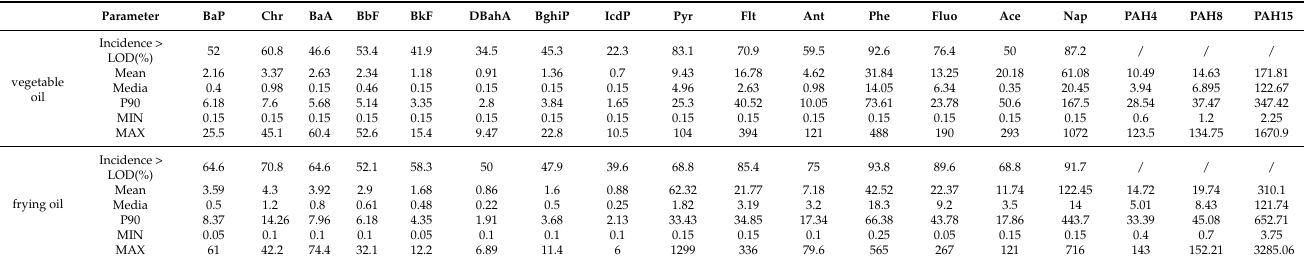
Table 4. Occurrence and contamination levels of PAHs in vegetable and frying oils in